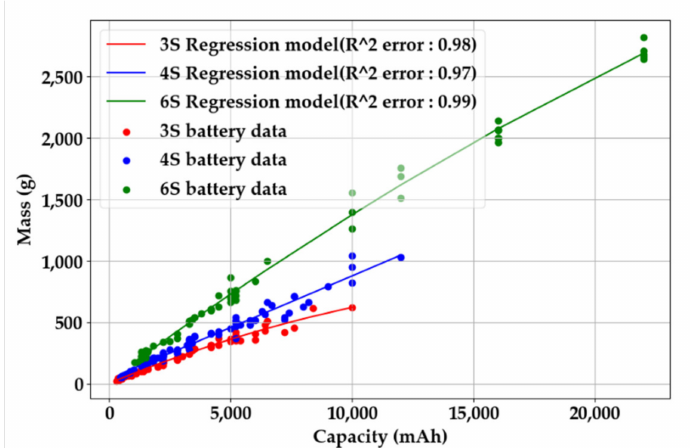
Figure 12. Regression model of a Li-po battery. The accuracy of the model was measured by the R -squared error, and the accuracy was high at 0.98, 0.97, and 0.99. The unit of capacity of the battery is expressed in mAh, and mass of the battery in grams